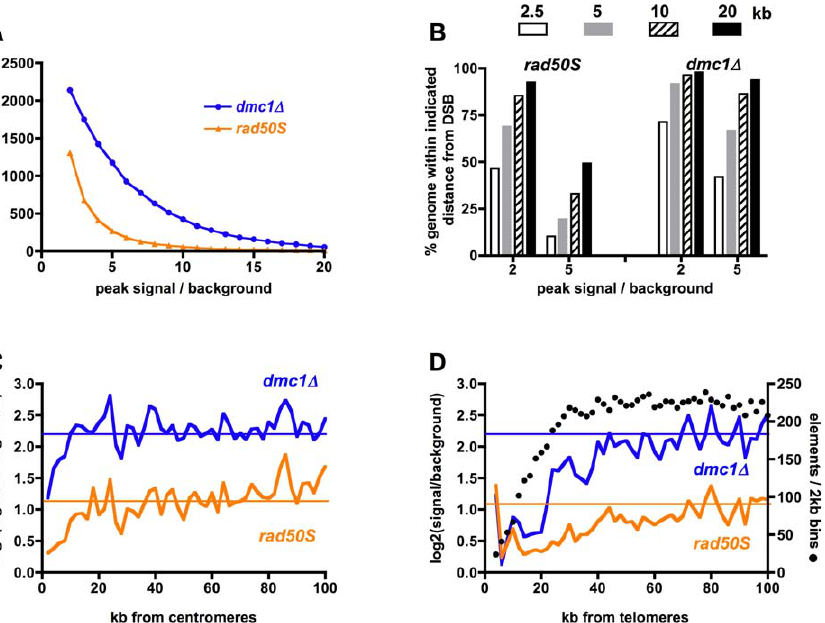
Figure 4. Summary of DSB Distributions (A) The number of DSB hot spots in dmc1 D (blue) exceeds the number in rad50S (orange) at all DSB intensities. DSB peaks were identified from smoothed data (Materials and Methods). Total DSB hot spots with peak heights greater than the indicated multiple of background are plotted. (B) More of the genome is close to a DSB in dmc1 D than in rad50S . The graph shows the fraction of the genome less than the indicated distance from a DSB peak with a height greater than 2-fold or 5-fold above background. (C) DSBs are reduced in a 8–10-kb region near centromeres. All 32 chromosome arms were aligned at the centromere, and the average unsmoothed enrichment signal was determined for all elements in 2-kb bins ( . 200 array elements/bin). Horizontal lines indicate genome-wide average. (D) DSB activity near chromosome ends. All 32 chromosome arms were aligned at chromosome ends, and the average enrichment signal was determined in 2-kb bins as for centromeres. Horizontal lines indicate genome-wide average. Black dots indicate number of array elements per 2-kb bin with homology to the SK1 strains used here (see Materials and Methods).